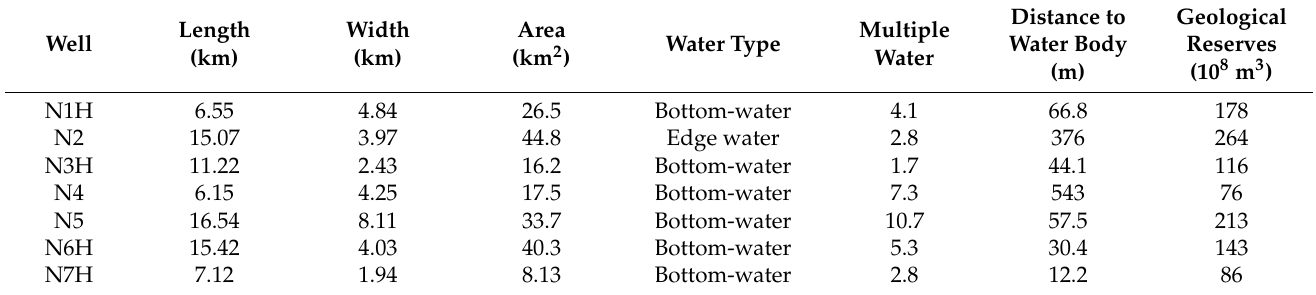
Table 2. Water distribution characteristic parameters of each well in the LS17 gas